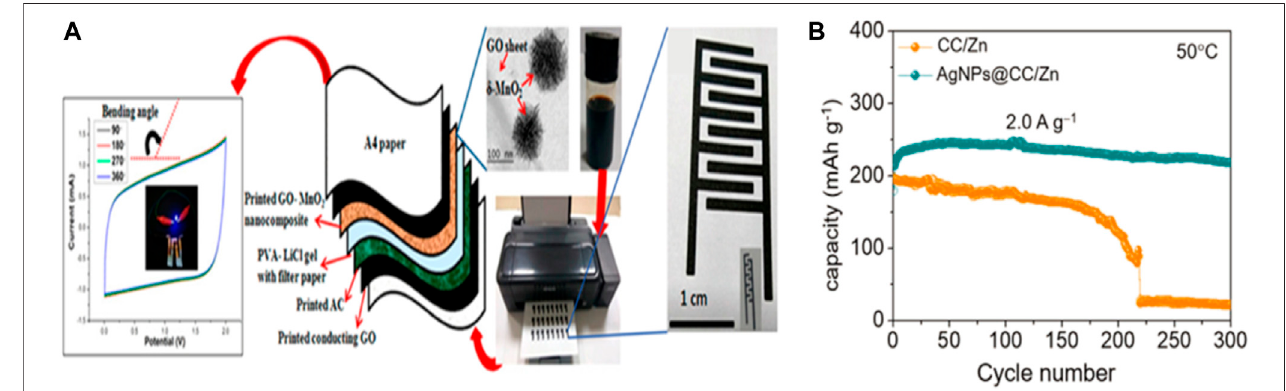
FIGURE10|(A) Schematicofinkjet-printedMnO 2 /GO-based fl exiblesupercapacitorsonA4papersubstratesusinganEPSONL130printer.Left:CVcurvesofthe fl exible supercapacitors under various bending angles. Reproduced with permission from P. Copyright 2017 American Chemical Society. (B) Use the CC/zinc and